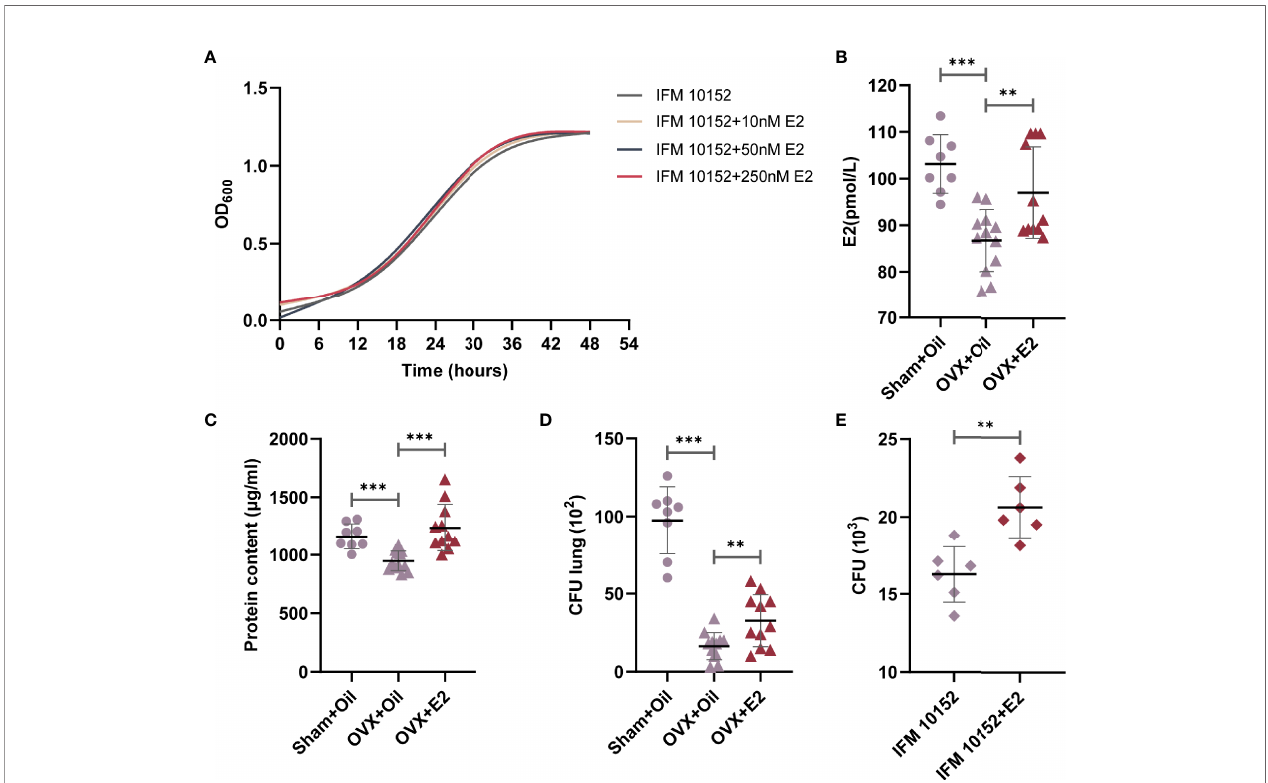
FIGURE 3 | E2 supplementation increases ovariectomized female mouse susceptibility to N. farcinica IFM 10152 lung infection. (A) Growth curve of N. farcinica IFM 10152 in BHI with 10 nM, 50 nM, and 250 nM for 48 hours. (B – D) Female mice were treated with sham ovariectomy with sesame seed oil (n=8), ovariectomy with sesame seed oil (n = 12), or ovariectomy with E2 (n = 12) prior to challenge with N. farcinica IFM 10152. (B) E2 levels in serum. (C) Protein content in BALF. (D) Bacterial burden in lung homogenates. (E) Bacterial survival in alveolar macrophages treated with or without E2. Lines display means with SEM. Data are from 2 independent experiments. ** P < 0.01, and *** P <